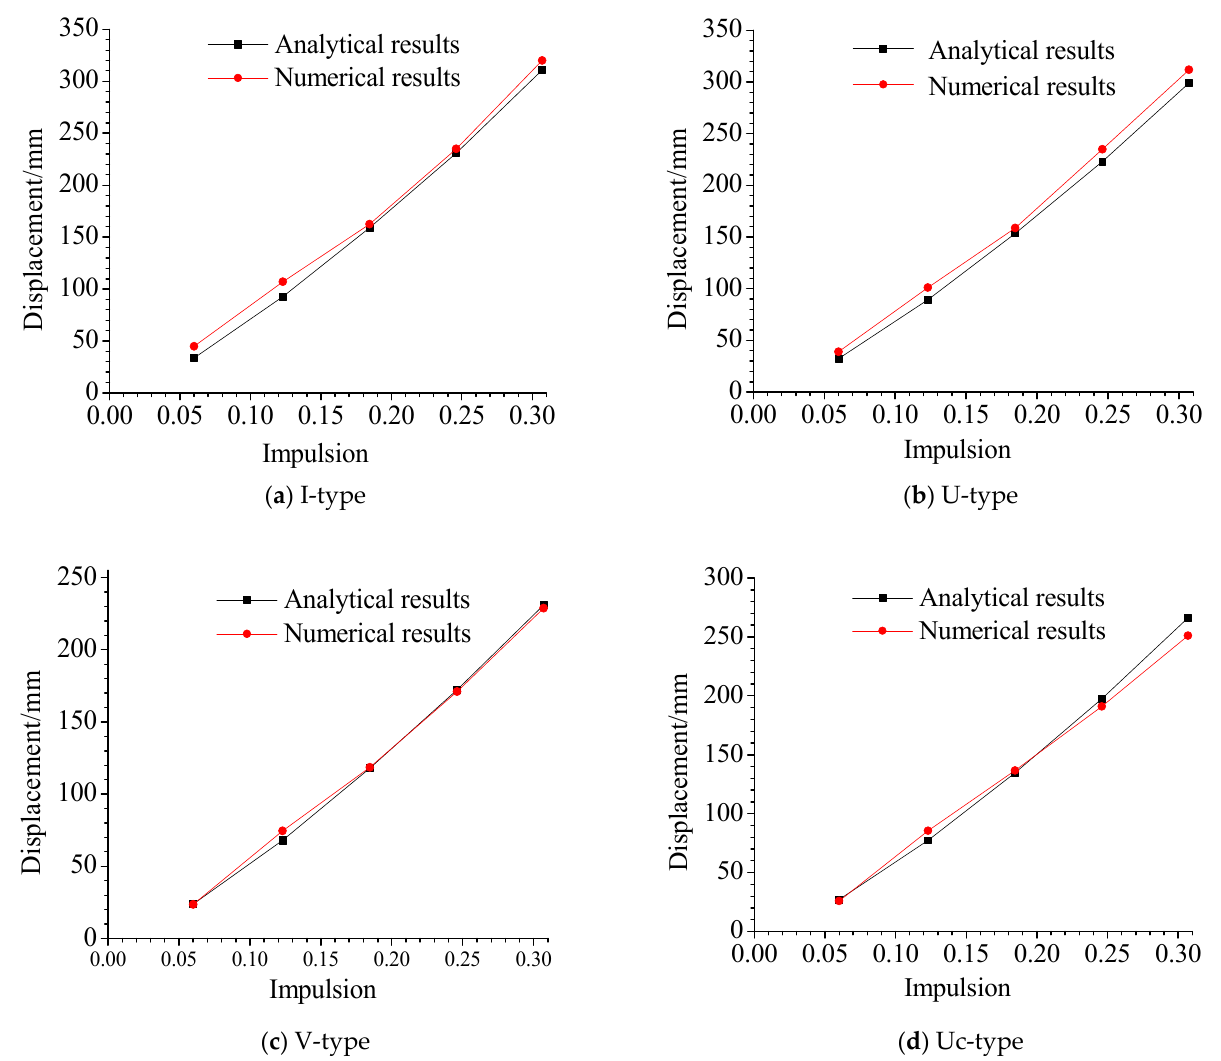
Figure 7. Impulsion ‐ displacement curves of the sandwich